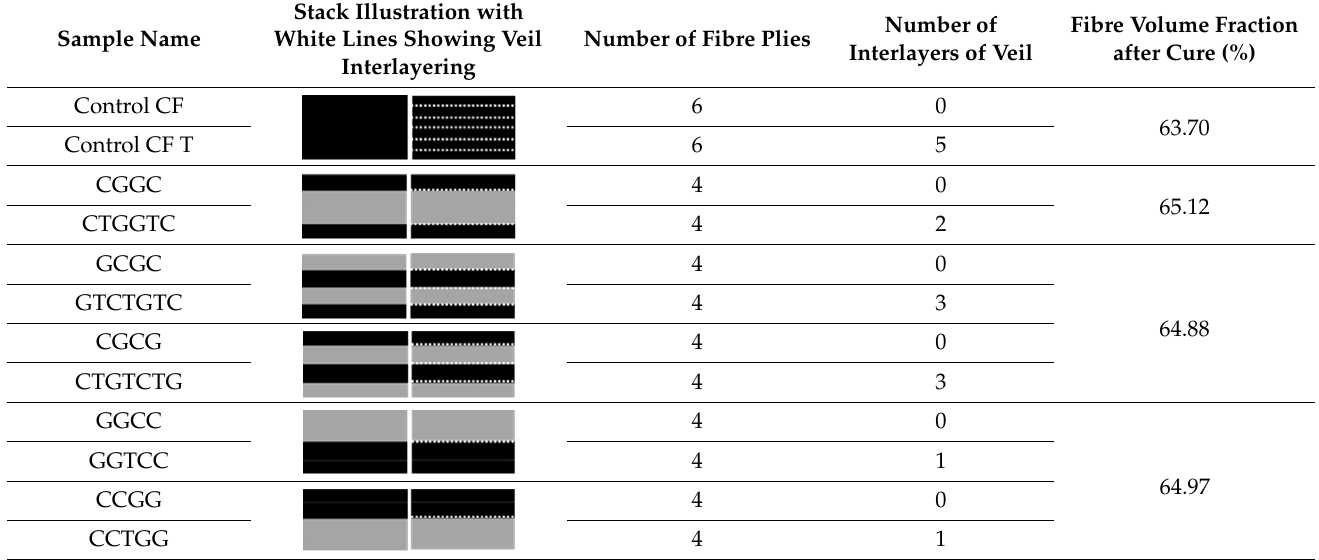
Figure 1. Differential scanning calorimetry, showing a peak at 155 °C consistent with manufacturing information. Table 2. Stacking Sequence for Hybrid Fibre Samples. Table 2. Cont.